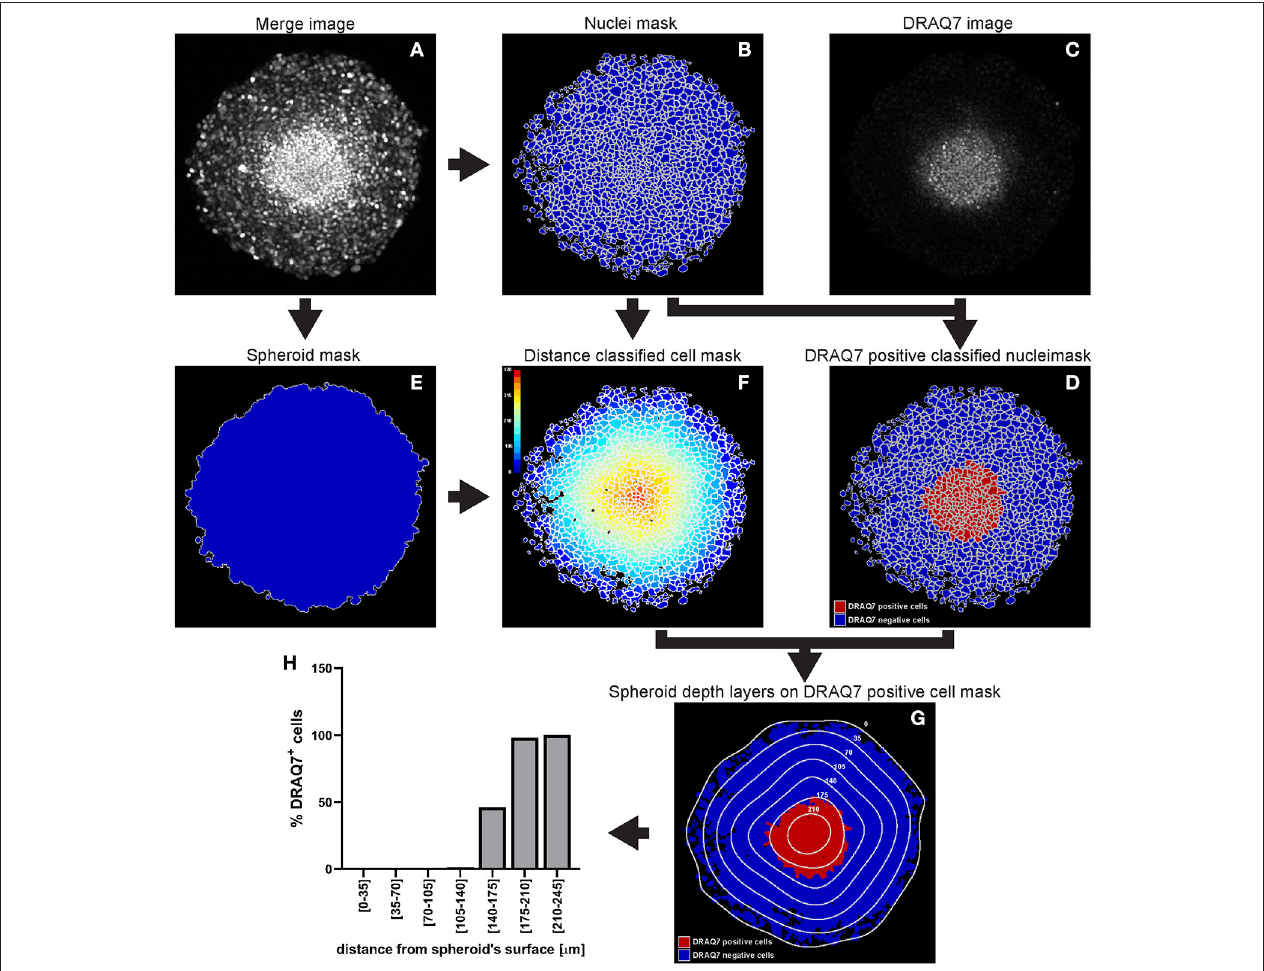
FIGURE 11 | Main steps of CellProfiler DRAQ7 image analysis. The Merge image (A) is used to identify the nuclei as primary objects (B) which together with the DRAQ7 image (C) are exploited to quantify DRAQ7 fluorescent signal for each nucleus and identify DRAQ7 positive nuclei (D) . The Merge image (A) is also used to determine the spheroid outline (E) which is in turn employed to measure the distance of each nucleus from the spheroid surface (F) . The data obtained from the CellProfiler analysis can be used to generate a distribution of the DRAQ7 positive cells at different depths in the spheroid (G,H) . The colour-coded scale (F) indicates the distance from the spheroid surface in µ m. In (G) the numbers labelling the depth curves indicate the distance from the spheroid surface in µ